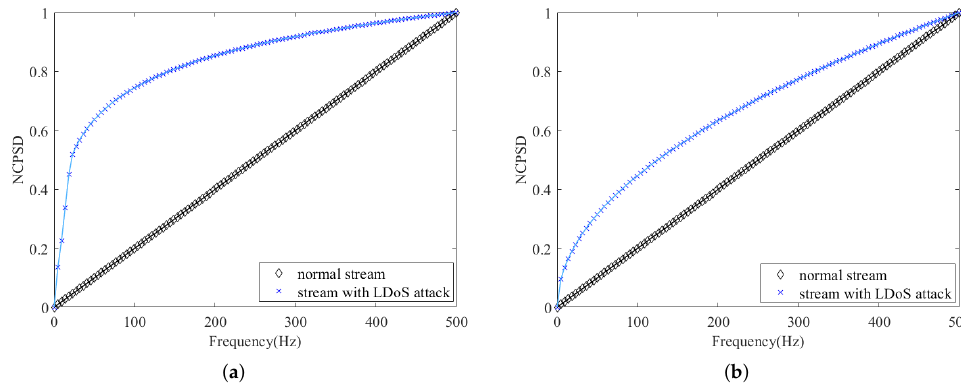
Figure 6. NCPSD under different background traffic intensity.( a ) NCPSD of attack stream and normal stream under low background traffic. ( b ) NCPSD of attack stream and normal stream under high background